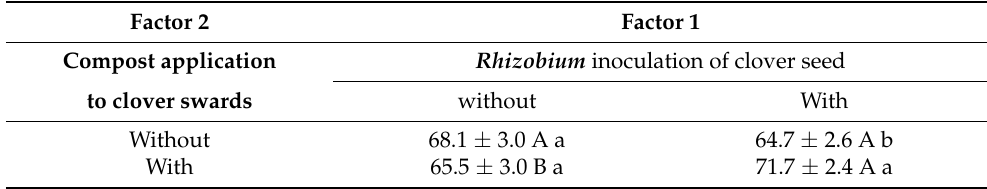
Table 11. Interaction means for effect of Rhizobium inoculation of clover seed and compost application to clover swards on the hardness of wheat grain grown after clover swards.